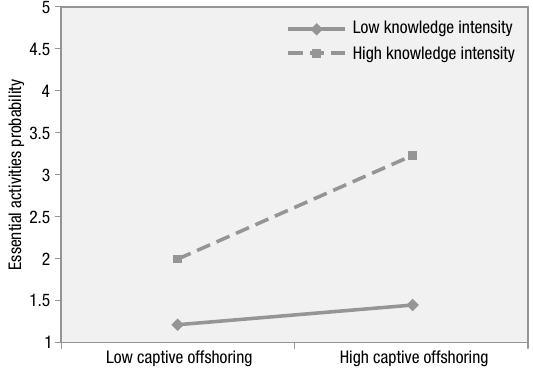
Fig. 5. Graph of offshoring modes and knowledge